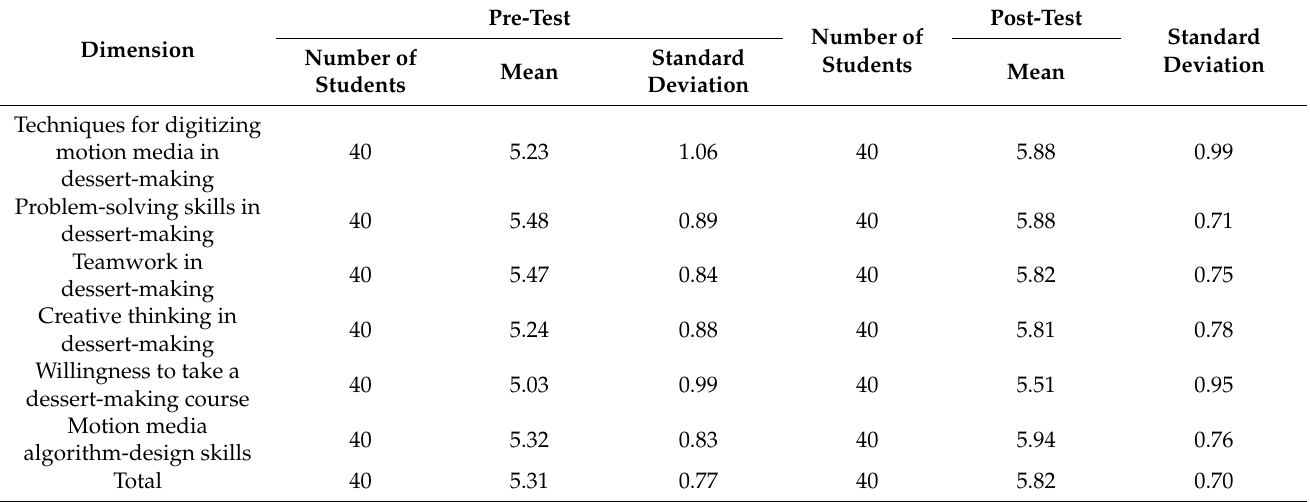
Table 2. Descriptive statistics of students’ learning outcomes.